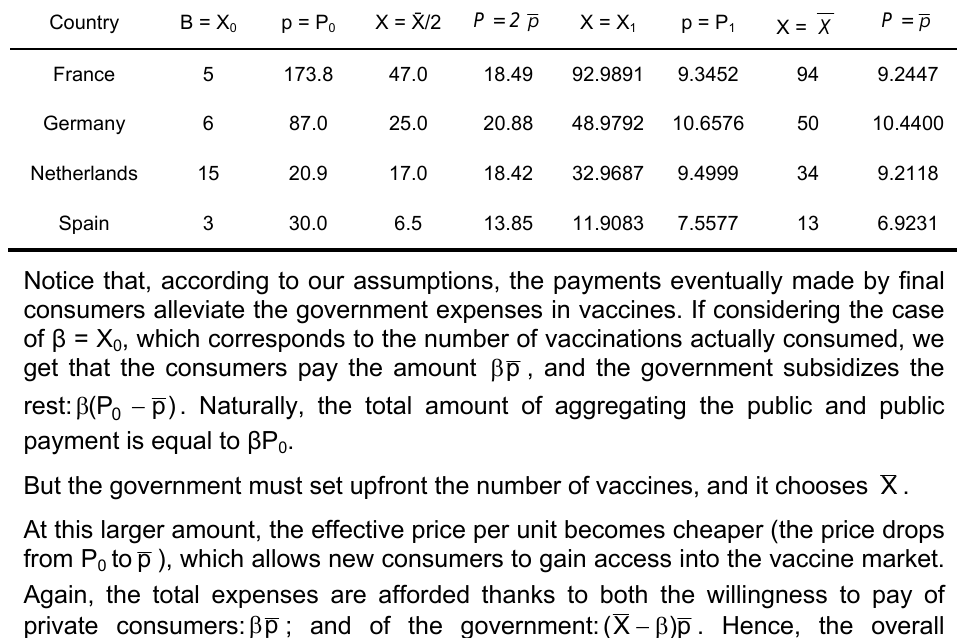
Table 5: Quantities and Prices. Influenza H1N1 Vaccine Market